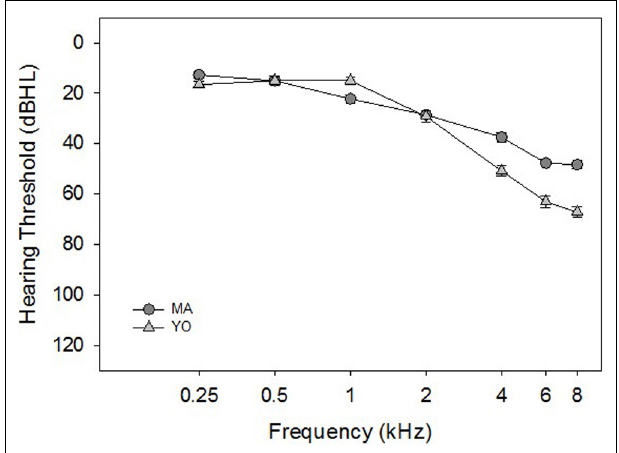
FIGURE 1 | Mean pure-tone thresholds (in dB HL) averaged across the right and left ears for the MA (circles), and YO (triangles) participants. Error bars represent (cid:6) 1